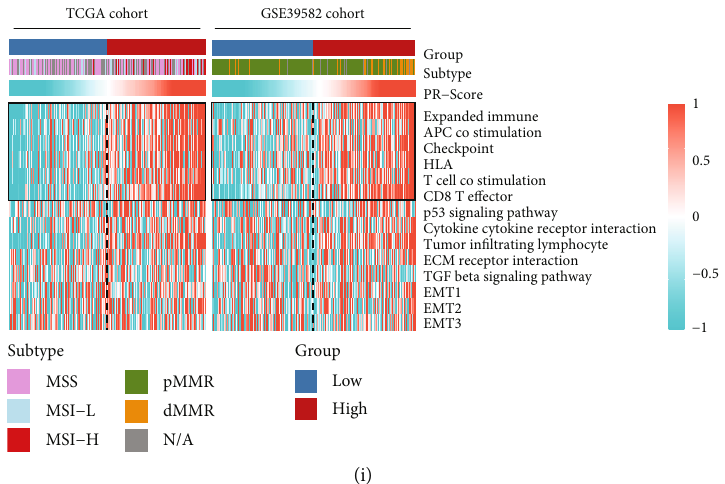
Figure 7: Relationships between the PR-Score/PR-signature, colitis-associated colorectal cancer (CAC), and colorectal cancer (CRC). (a) Comparison of the PR-Score in normal, IBD, adenoma, and CRC tissues using GSE4183. (b) Comparison of the PR-Score in colitis and UC-dysplasia tissues using GSE47908. (c) Correlation of the PR-Score and the progression from in fl amed dysplasia to adenocarcinoma. Correlation of the PR-Score and the molecules that suppress/promote tumors in UC samples (d) and CRC samples (e). The e ff ect of PR- Score on the OS and DFS of CRC in TCGA (f) and GSE39582 (g). (h) Di ff erences of PR-Score between normal and tumor in TCGA and GSE39582. (i) Correlations of the PR-Score and the tumor immune-related pathways and CRC subtypes in TCGA and GSE39582. IBD: in fl ammatory bowel disease; CAC: colitis-associated colorectal cancer; CRC: colorectal cancer; UC: ulcerative colitis; OS: overall survival; DFS: disease-free survival; MSS: microsatellite stability; MSI-H: high microsatellite instability; MSI-L: low microsatellite instability; pMMR: pro fi cient-mismatch-repair; dMMR: de fi cient-mismatch-repair; N/A: not applicable. ∗ P < : 05 , ∗∗ P < : 01 , ∗∗∗ P < : 001 , and ∗∗∗∗ P < : 0001 . ns: not signi fi